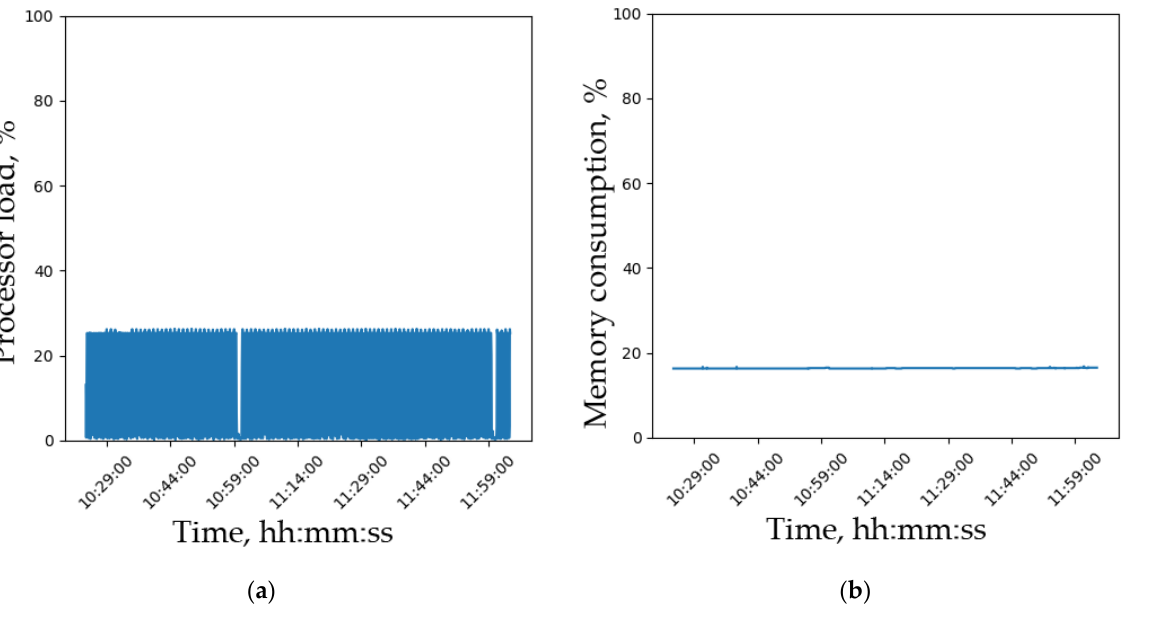
Figure 7. System resource consumption with run moduli. ( a ) — processor load; ( b ) — memory con- Figure 7. Systemresourceconsumptionwithrunmoduli. ( a )—processorload; ( b )—memoryconsumption. sumption. The control computer memory consumption (right panel) is also at the constant